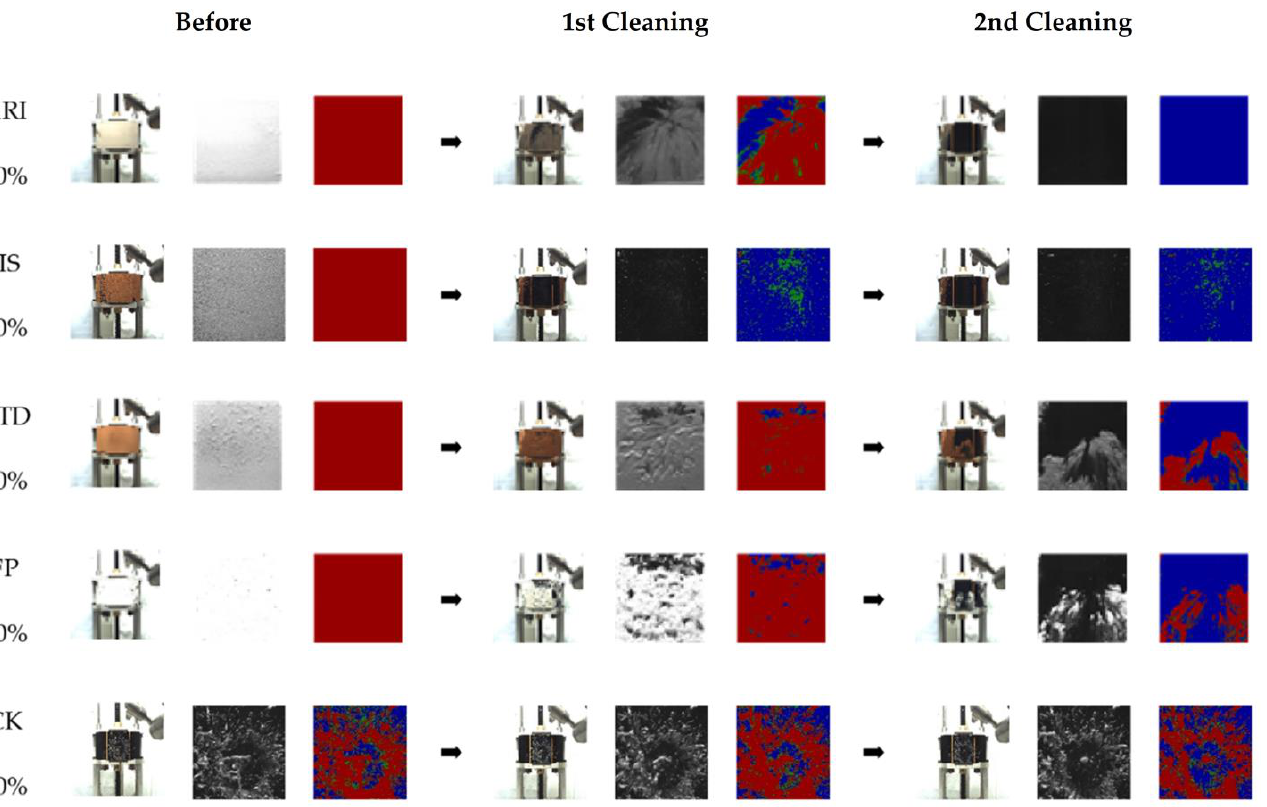
Figure 12. Images of the experimental process according to the type of dust (ARI, JIS, KTD, FP, CK). Items are arranged in order according to the stages of before washing, first washing, and second washing. The image of each item is expressed using a real photo, black-and-white photo, and photo of the washing area expressed in RGB.